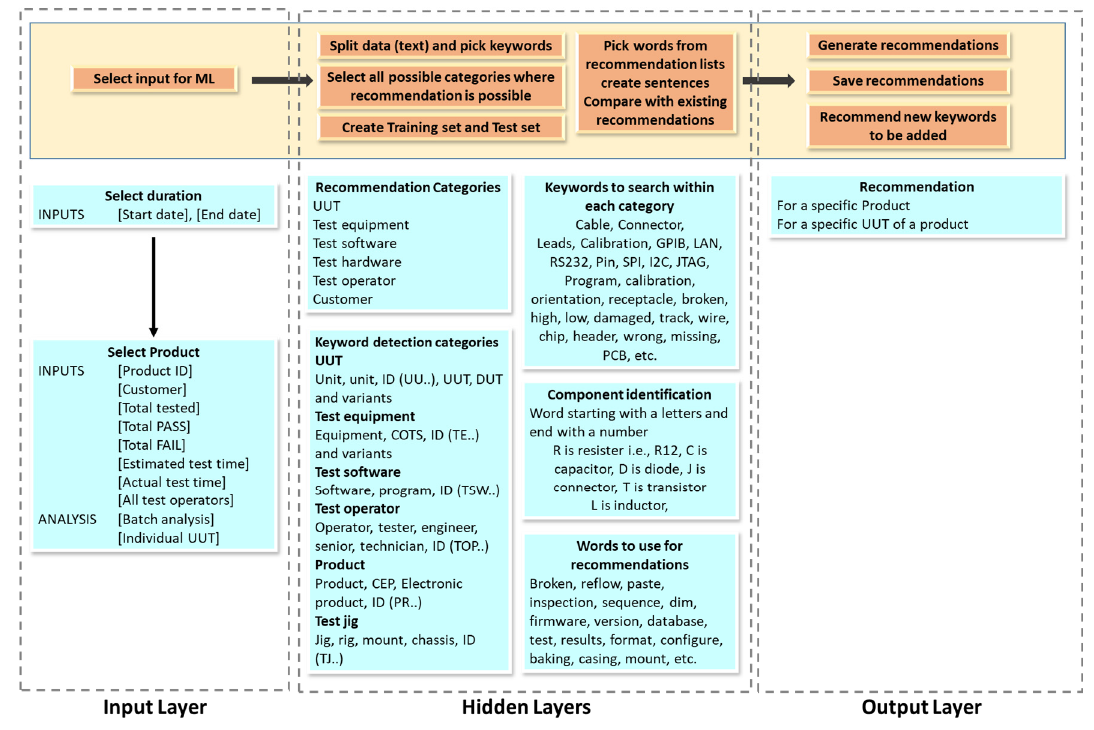
Figure 7. Machine-learning structure for automated recommendations.